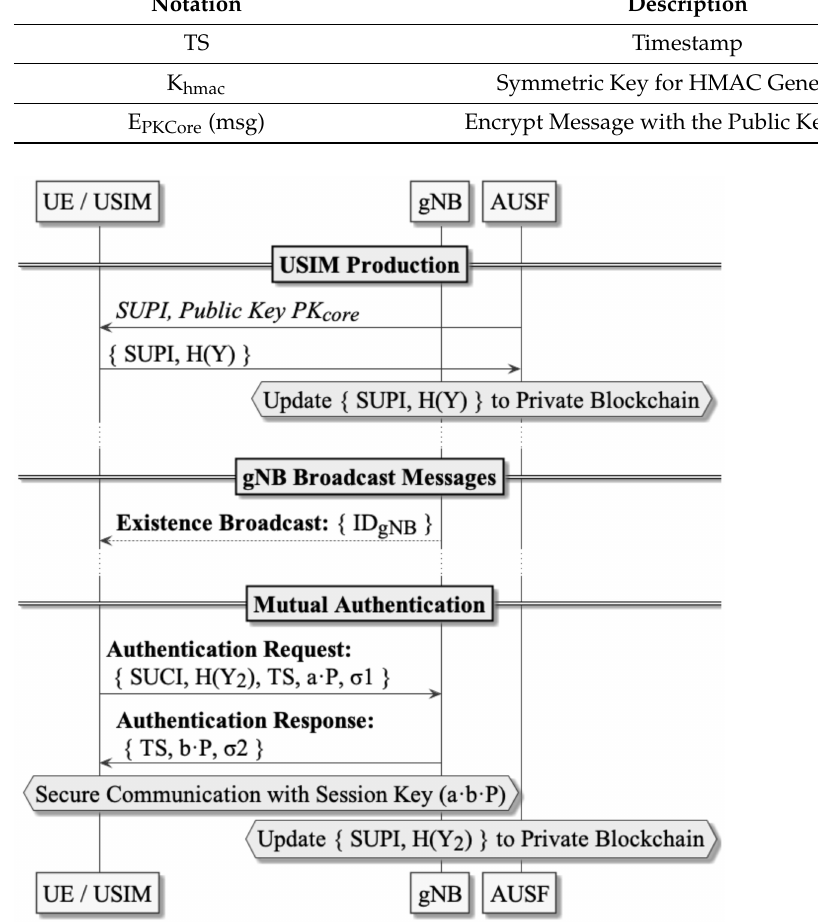
Figure 2. Sequence Diagram of